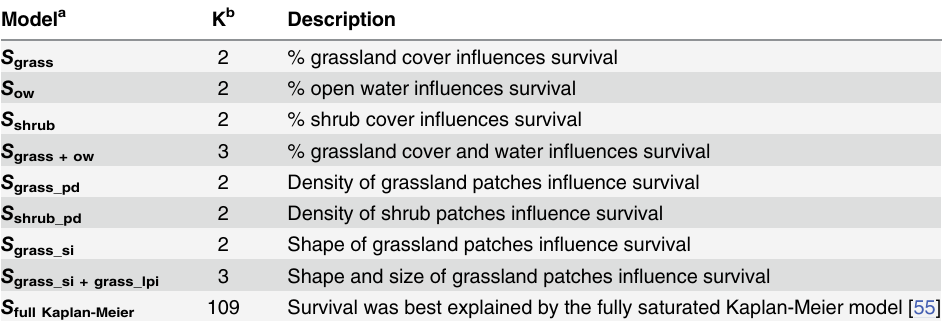
landscape shape index (i.e., standardized measure of the edge for all cover type patches; [50]). To minimize potential confounding effects of heterogeneity in size of circular analysis regions between study sites on survival estimates, we excluded mean shrub, open water, and grassland patch area variables (Table 1) from our analyses. We included capture year, age at capture, birth mass, sex, and parturition date as intrinsic covariates in survival models. Though relative coyote densities were unknown across our study sites, we included study site (e.g., proxy for relative coyote density) as an intrinsic covariate in survival models to test whether differing coyote densities resulted in differential mortality due to predation or whether regional varia- tion in coyote densities influenced habitat selection by neonatal pronghorn. Prior to modeling, we screened all independent variables for collinearity using Pearson ’ s correlation coefficients (|r| > 0.5) and used quantile plots to evaluate assumptions of normality [51]. We used only 1 Table 2. A priori candidate models constructed to determine potential effects of habitat variables on survival of neonatal pronghorn in western South Dakota, USA, 2002 – 2005. Model a